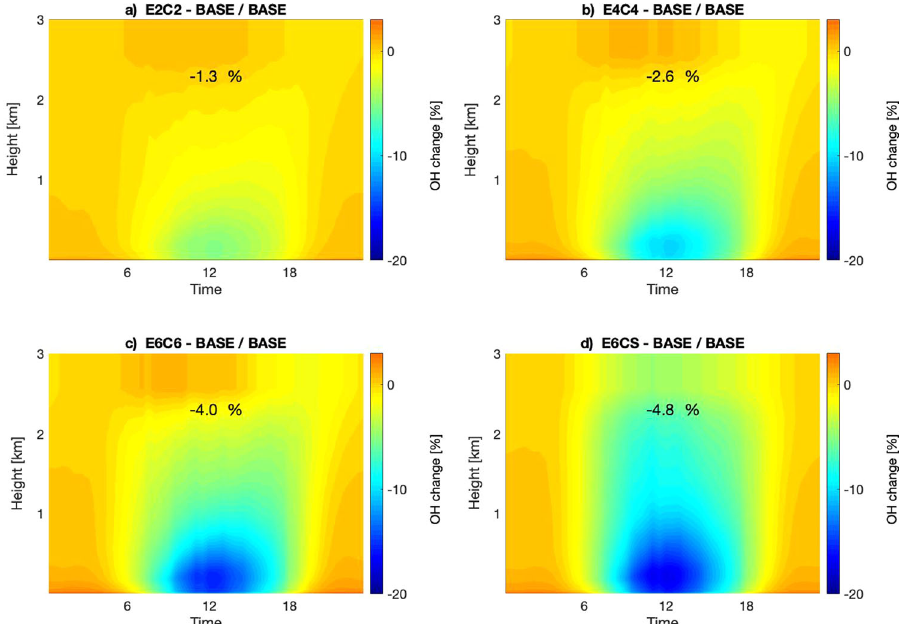
Fig. 2 Hydroxyl radical relative change. a – d The percentage change of OH concentrations between four scenarios and the BASE run relative to the maxima at each height level averaged for daily distribution for the whole year 2016. The scenario abbreviations EXCX stands for E = emission, C = chemistry, X = temperature increase in the related module(s) and S stands for the scenario where only the fi rst reaction of the reactions of terpenes with OH, NO 3 and O 3 were increased by 6 K. The percentage changes for the height interval 0 m – 3 km are indicated as inline